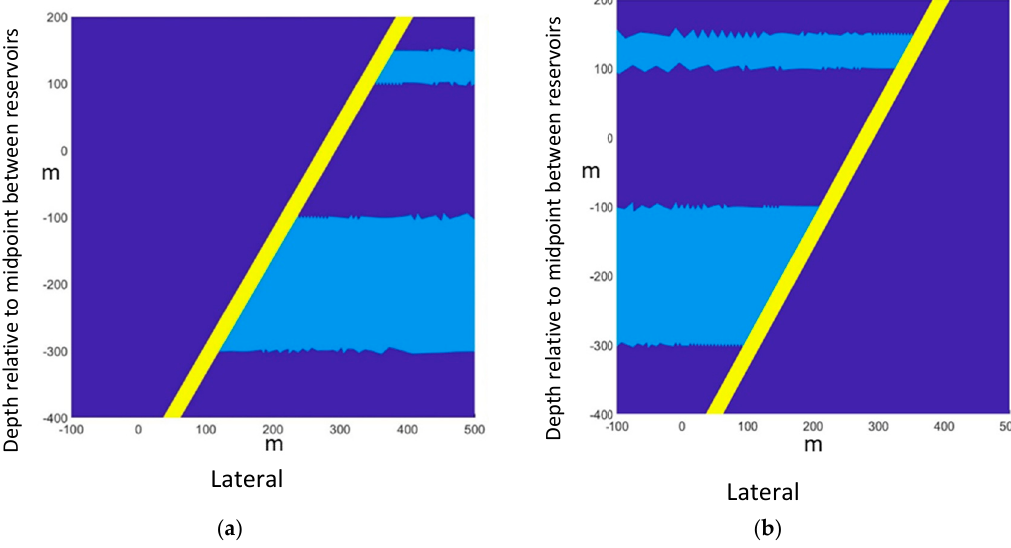
Figure 4. Assignment of rock types to the domain elements. Dark blue: shale (caprock, underburden, overburden, and footwall at left ( a ) or hanging wall at right ( b )). Light blue: sandstone (lower and upper reservoirs). Yellow: fault damage zone (process zone). Axes: distance in meters.